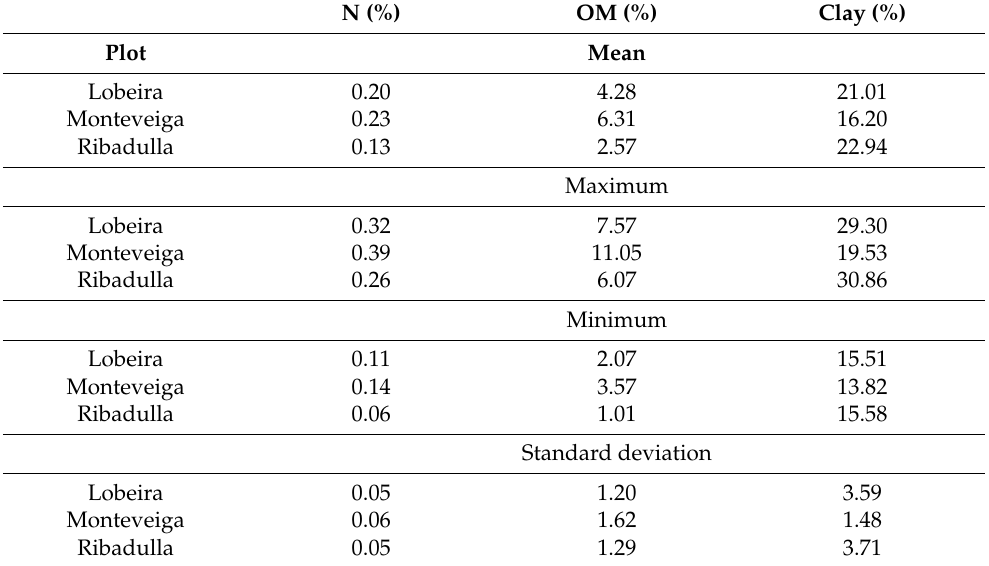
Table 1. Basic statistics for the soil samples data set ( n = 96, 32 per plot). Results of laboratory analysis for N, OM and clay